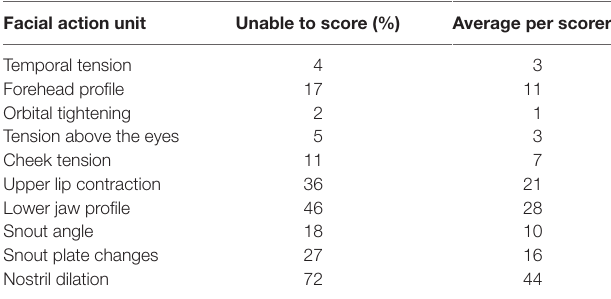
TaBle 2 | Percentages and average number per scorer of “don’t know” responses for each FaU based on a total of 94 images. Facial action